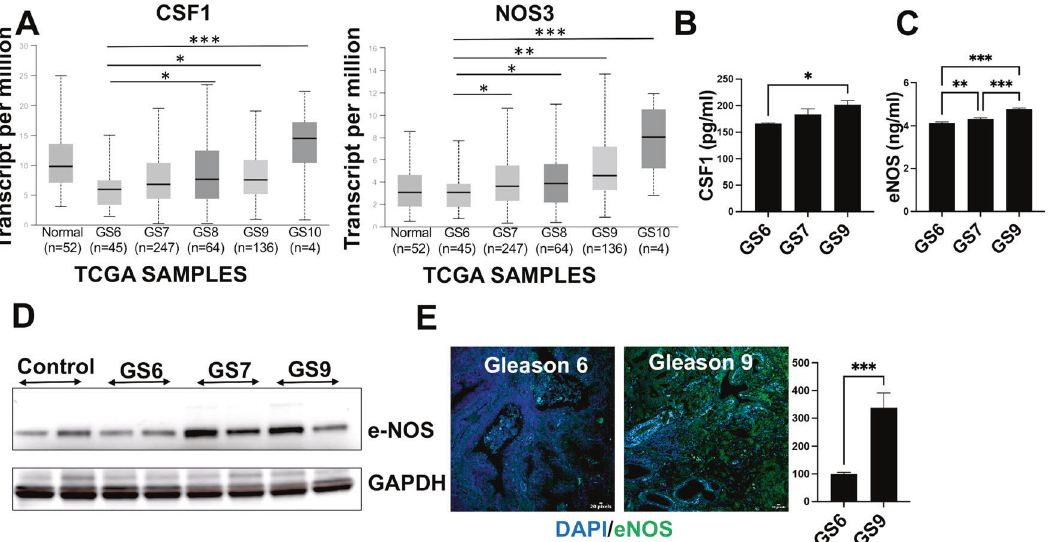
Fig. 1 Prostate cancer progression is associated with increased CSF1 concentration and Nitric oxide synthases. The relative expression of CSF1 and NOS3 was studied using RNA sequencing data for Prostate adenocarcinoma from The Cancer Genome Atlas (TCGA). A Graphs showing expression of CSF1 and NOS3 across different Gleason Grades. B Quanti fi cation of CSF1 and C NOS3 was done by enzyme-linked immunosorbent assay (ELISA) performed in PBMCs collected from different patient blood samples with different Gleason grades ( n = 2). CSF1 levels are expressed as pg/ml, while NOS3 levels are expressed as ng/ml. D Western blot following immuno-precipitation of Peripheral Blood Mononuclear Cells (PBMCs) showing the expression of NOS3 (NOS3) ( n = 2). E Immuno fl uorescent staining images showing expression of NOS3 (green) in patient biopsies from Gleason Grade 6 and 9. Data are means ± SEM. n , number of samples. GS, Gleason grade. * p < 0.05; ** p < 0.01; *** p <